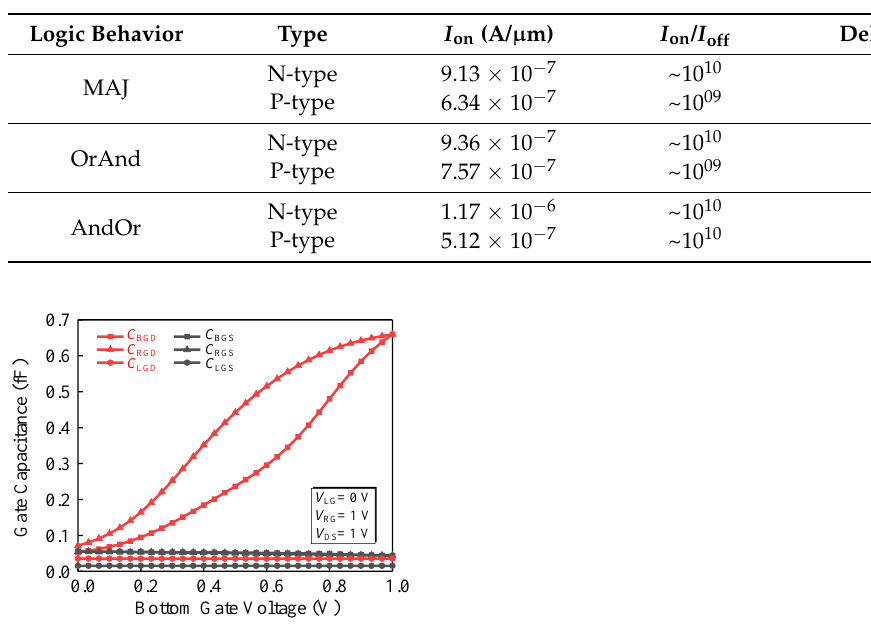
Figure 13. Capacitance characteristics of the proposed device. C BGS , C RGS , and C LGS indicate the gate-source capacitance, and C BGD , C RGD , and C LGD indicate the gate–drain capacitance.